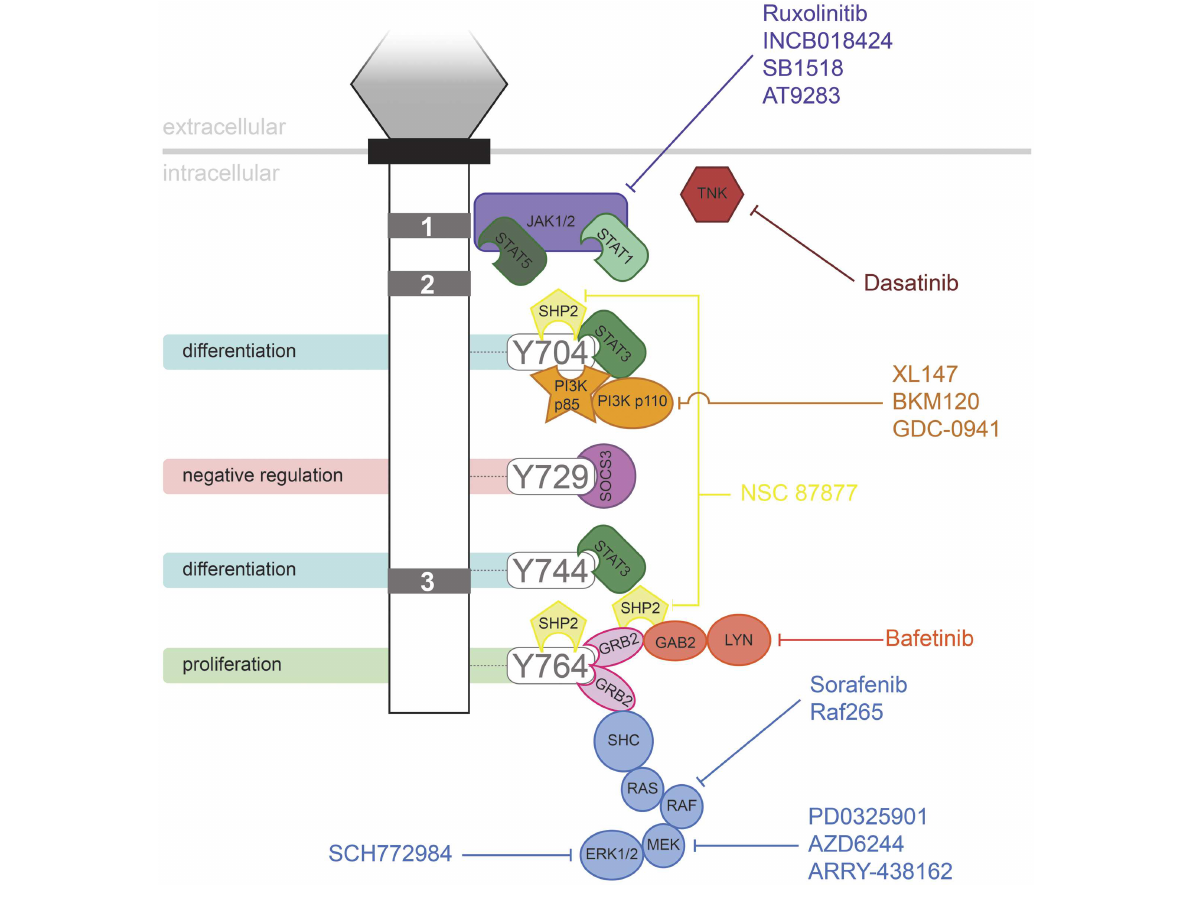
FIGURE 2 | Inhibitors of signaling pathways downstream of G-CSFR . Schematic representation of the intracellular domain of G-CSFR, showing the important Box 1–3 sequences (gray rectangles),